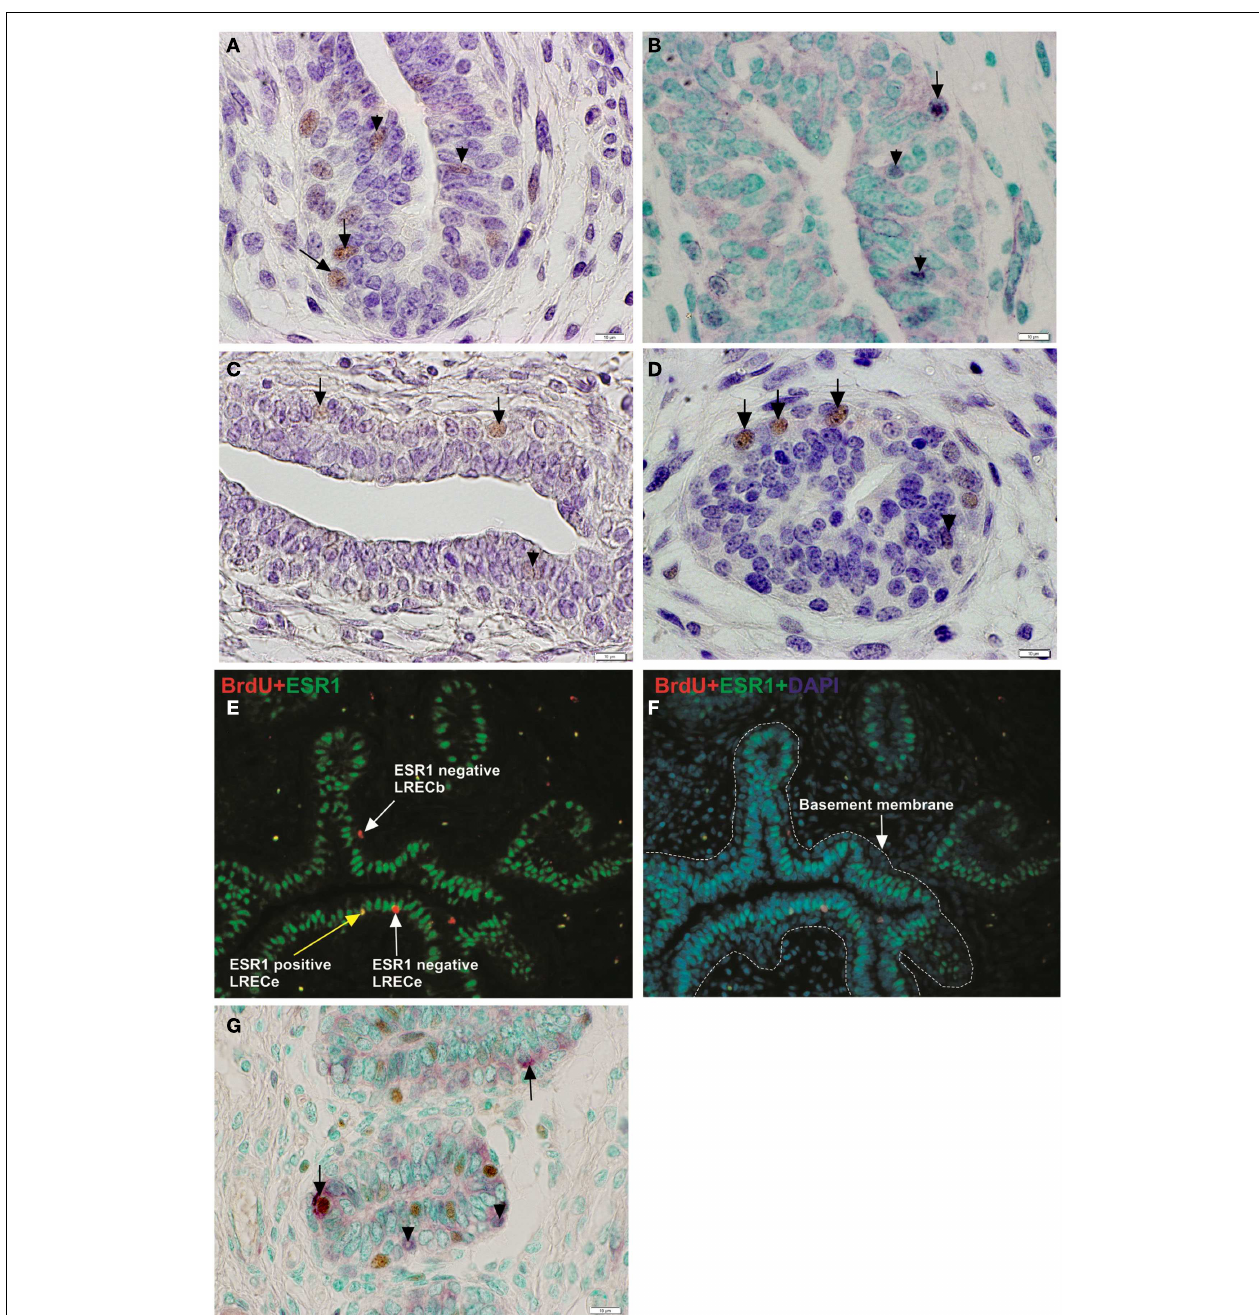
FIGURE 7 | Immunohistochemical localization of potential mammary stem/progenitor cell markers. (A–D) Consistent with transcriptome data, cells that were positive for these novel markers were more strongly labeled (brown nuclei) in the basal layer of mammary epithelium than in the embedded layers. Solid arrows designate labeled nuclei of basal cells and arrow heads designate labeled nuclei of embedded epithelial cells. NR5A2 ubiquitin/proteasome, DNA repair, and chromatin remodeling